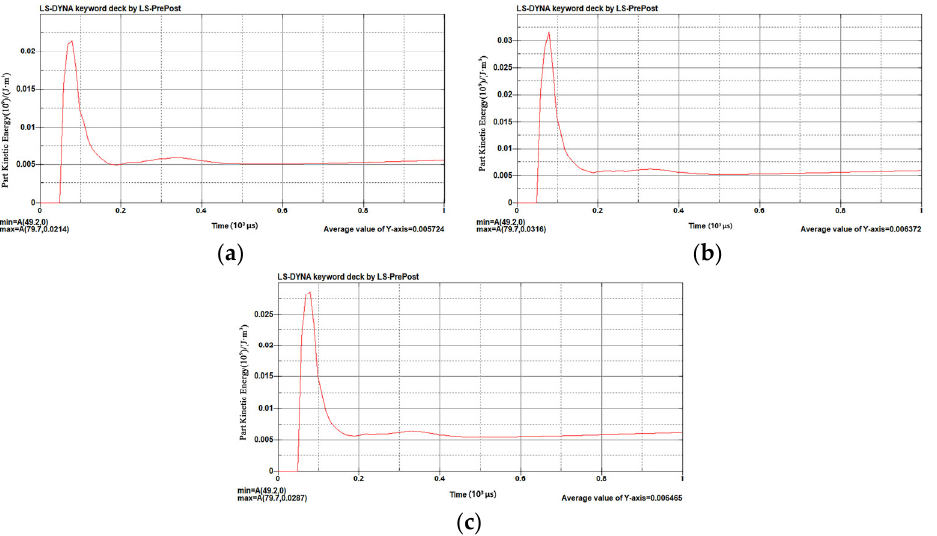
Figure 5. ( a ) Top ignition; ( b ) central ignition; ( c ) bottom ignition.